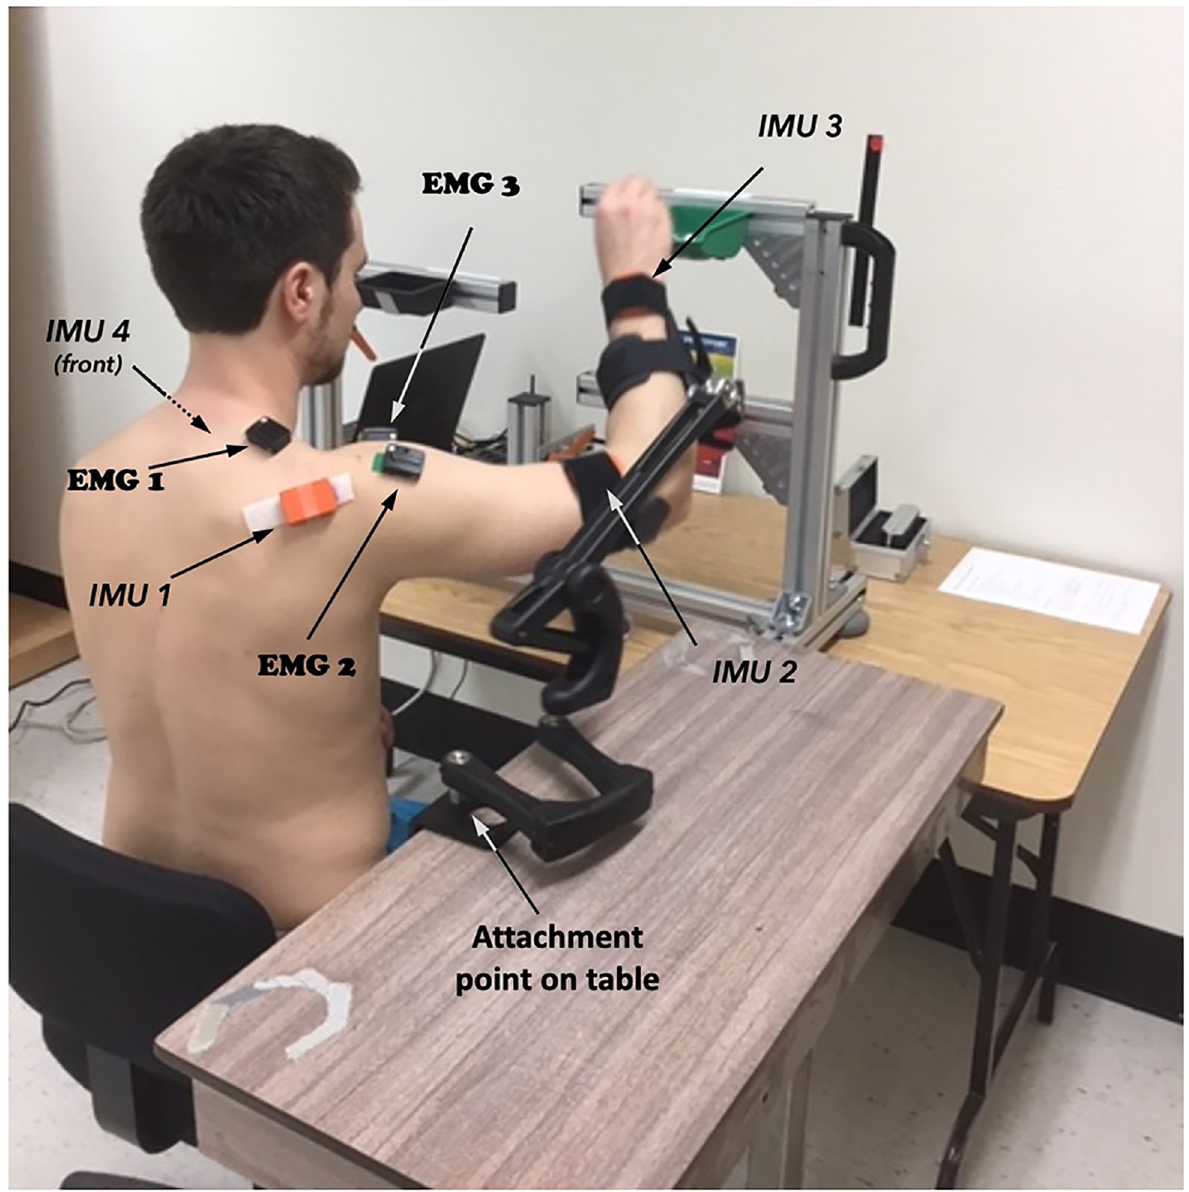
Fig 1. Positions of the three-dimensional dynamic arm support, of the surface electromyographic (EMG) sensors and of the inertial measurement unit (IMU) sensors during the dynamic task. EMG1, upper trapezius; EMG2, middle deltoid; EMG3, anterior deltoid. IMU1, scapula; IMU2, arm; IMU3, distal forearm, IMU4 (not shown on the figure),